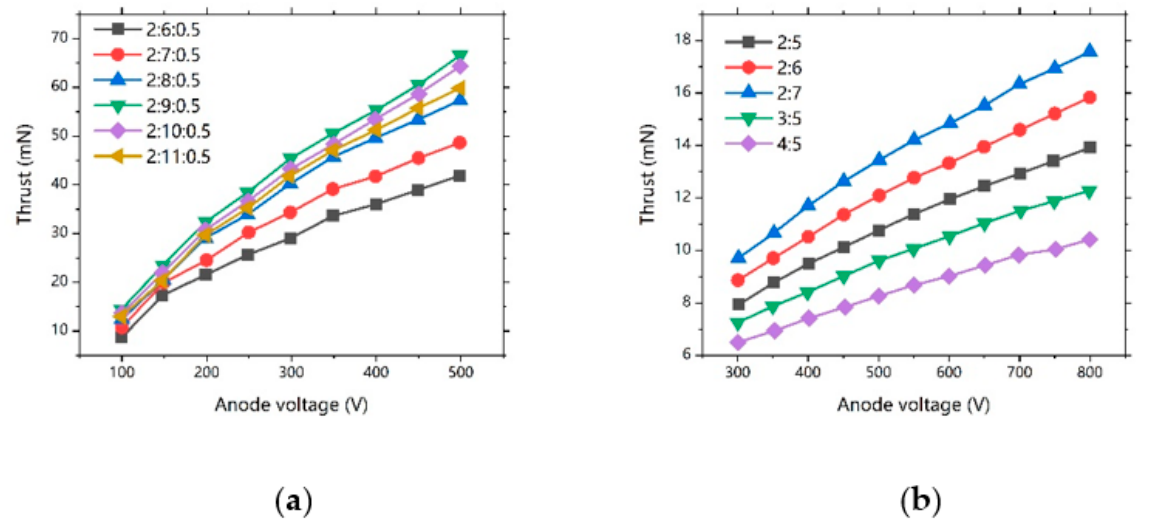
Figure 8. Experimental investigation results (thrust) of different ( a ) magnet length and ( b ) ratio.